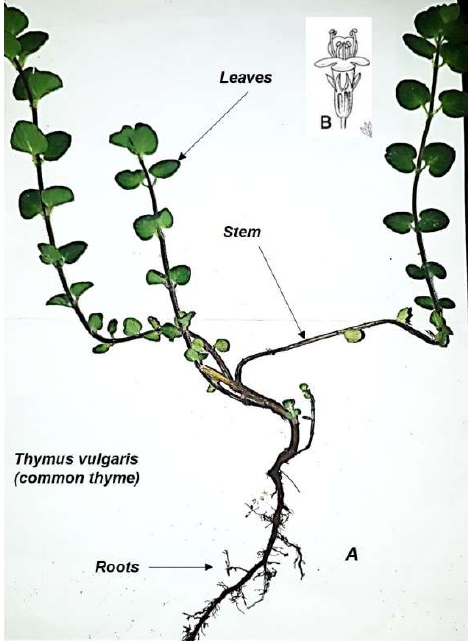
Figure 1. Thymus vulgaris (common thyme), sketch drawing, not necessarily to scale. ( A ) Plant vegetative parts: leaves, stem, and roots. ( B ) Reproductive part: flower of a cyme type, purple and white color, bisexual and two-lipped with a hairy glandular calyx responsible for a pleasant scent. The sketch is courtesy of the authors.